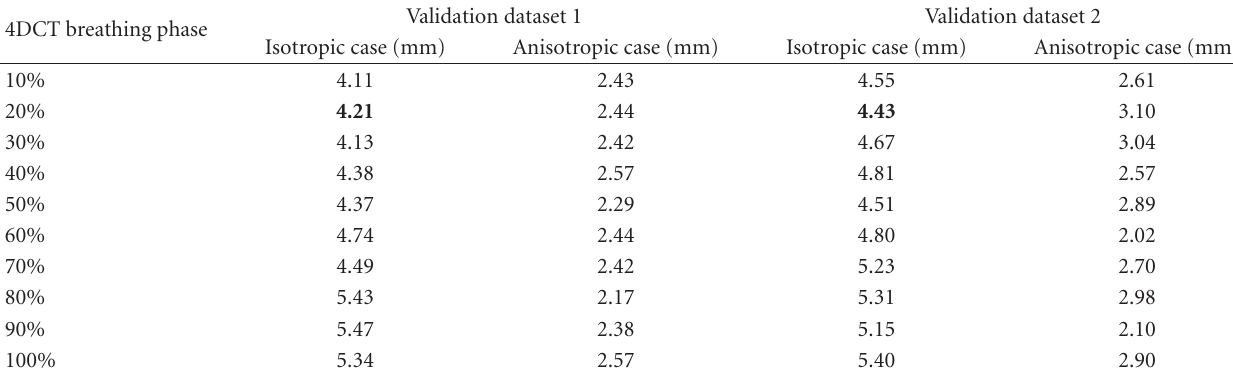
Figure 10: Predicted displacement for nodes A, B, and C over 6 breathing cycles with isotropic YM. Table 1: The mean target deformation error (TDE) for the